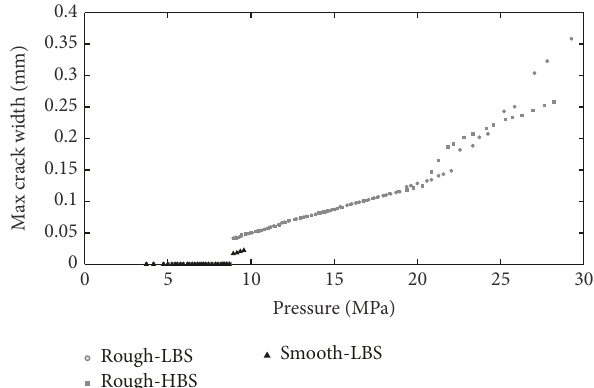
Figure 13: Influence of interface strength and substrate surface roughness on imposed internal pressure and corresponding maxi- mumcrackwidthspriortorepairsystemfailure.Plainmortarisused asarepairmaterial(LBScorrespondstointerfacestrength1MPaand HBS to interface strength